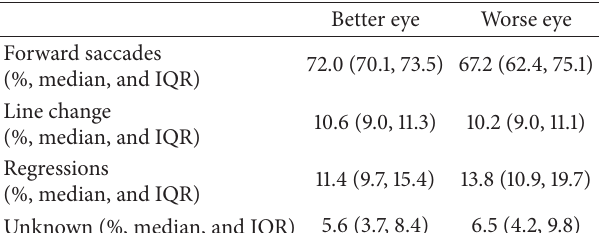
Table 3: Proportion of saccades that were forward, between lines, regressions, or unknown when reading with the best eye and worse eye,